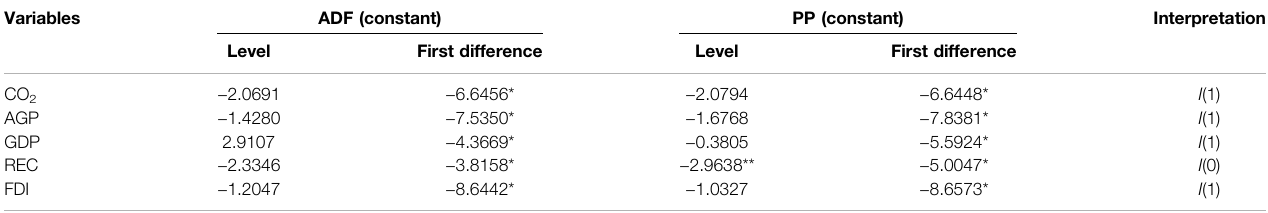
TABLE 2 | Unit root test using the augmented Dickey – Fuller (ADF) and Phillips – Perron (PP) tests. Variables ADF (constant) PP